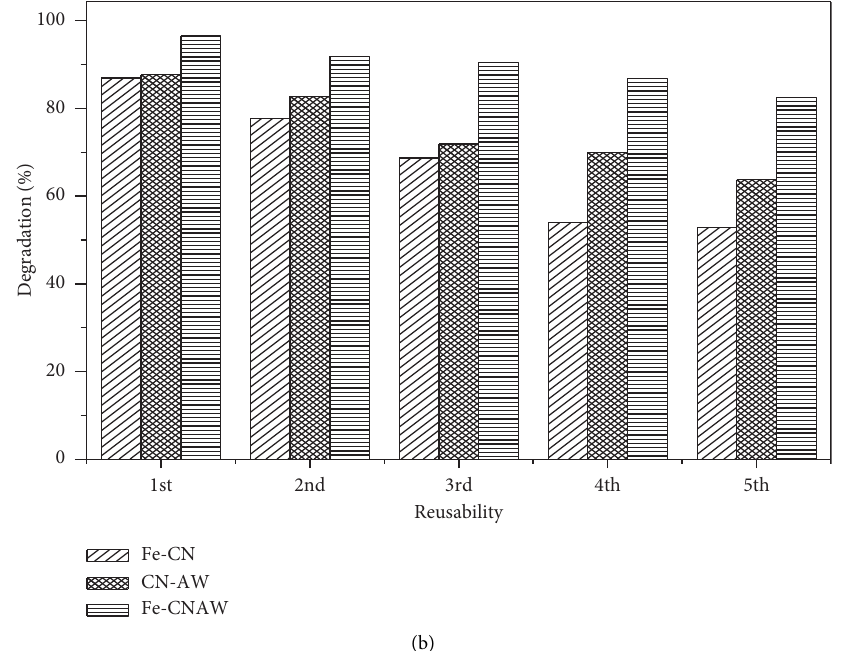
Figure 11: (a) Experiment on the role of several radical scavengers and (b) reusability experiment by Fe-CN, CN-AW, and Fe-CN-AW nanocomposites. Table 3: Comparison of the degradation performance of metal/nonmetal doped g-C Sr. no.